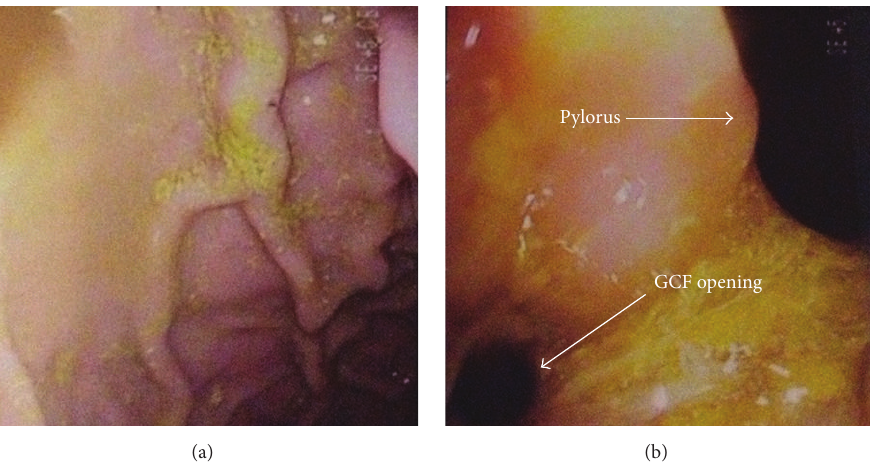
Figure 1: (a) Gastroscopy showing normal gastric rugae with no erythema or ulceration. (b) Gastroscopy showing the opening to the GCF adjacent to the pylorus.